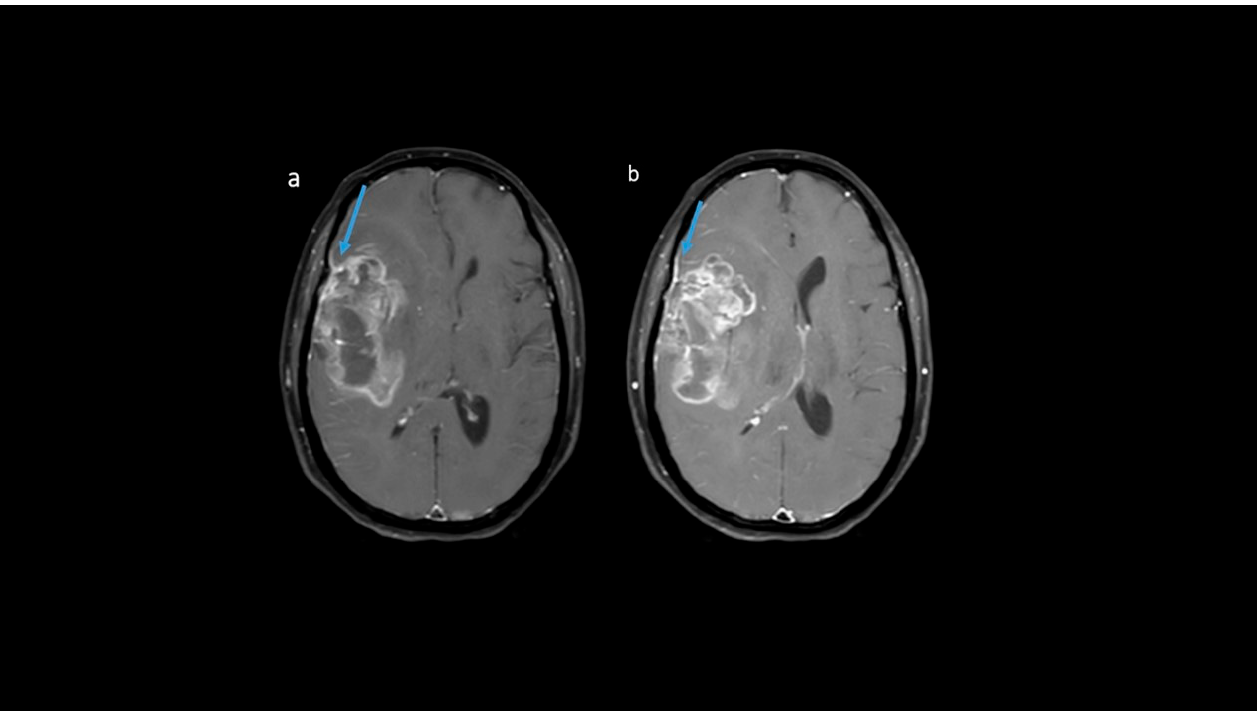
Figure 10. ( a – d ) T1 + C images from four patients showing various proportions of necrosis: ( a ) none,